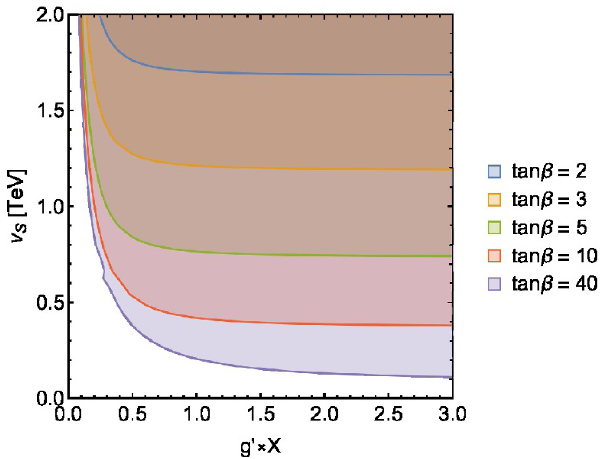
Figure 12. The allowed 95% CL regions in the v S versus g 0 X plane for (cid:12)xed tan (cid:12) = 2 ; 3 ; 5 ; 10 ; 40 [Blue, Yellow, Green, Red, Purple] from the constraints M Z and partial widths (cid:0)[ Z e; (cid:22); (cid:28) ), imposing M Z < M Z 0